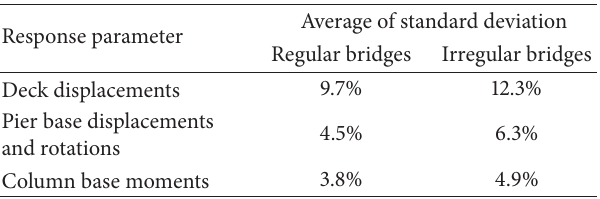
Table 2: Accuracy of the proposed method for regular and irregular